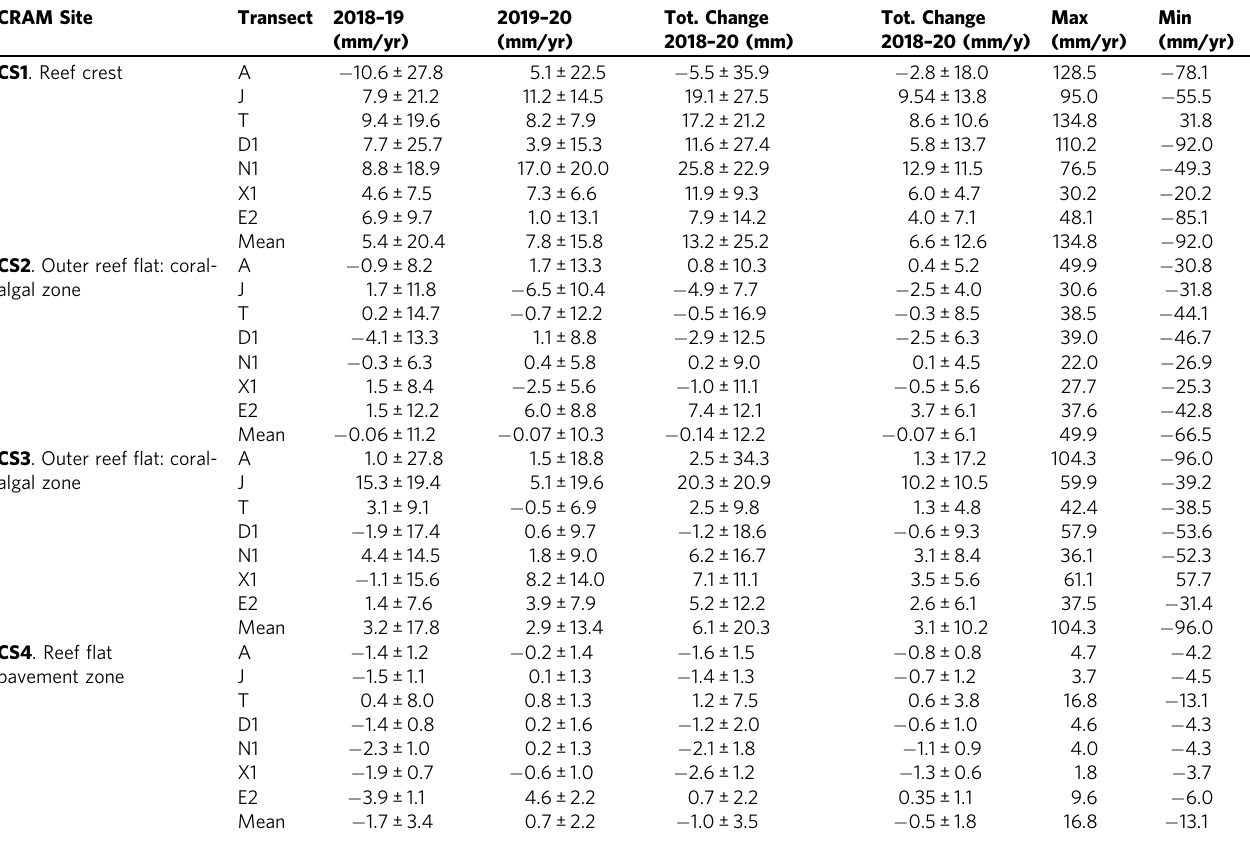
Table 1 Summary changes in reef surface elevation at Coral Reef Accretion Monitoring (CRAM)